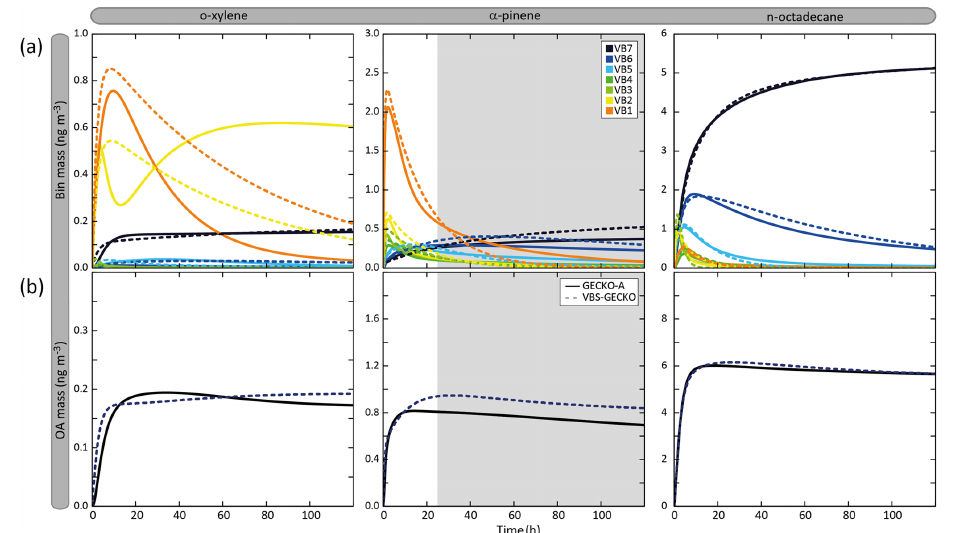
Figure 6. Temporal evolution of volatility bin mass concentration (a) and organic aerosol mass (b) simulated with GECKO-A (continuous lines) and VBS-GECKO (dashed lines). Simulated results are shown for o-xylene, α -pinene and n-octadecane for the scenario performed at a temperature of 298K, a zenith angle of 50 ◦ , a C oa of 1µgm − 3 , 40ppb of ozone and a RRR of 90%. Parameters have been optimized on duration represented by white background on the